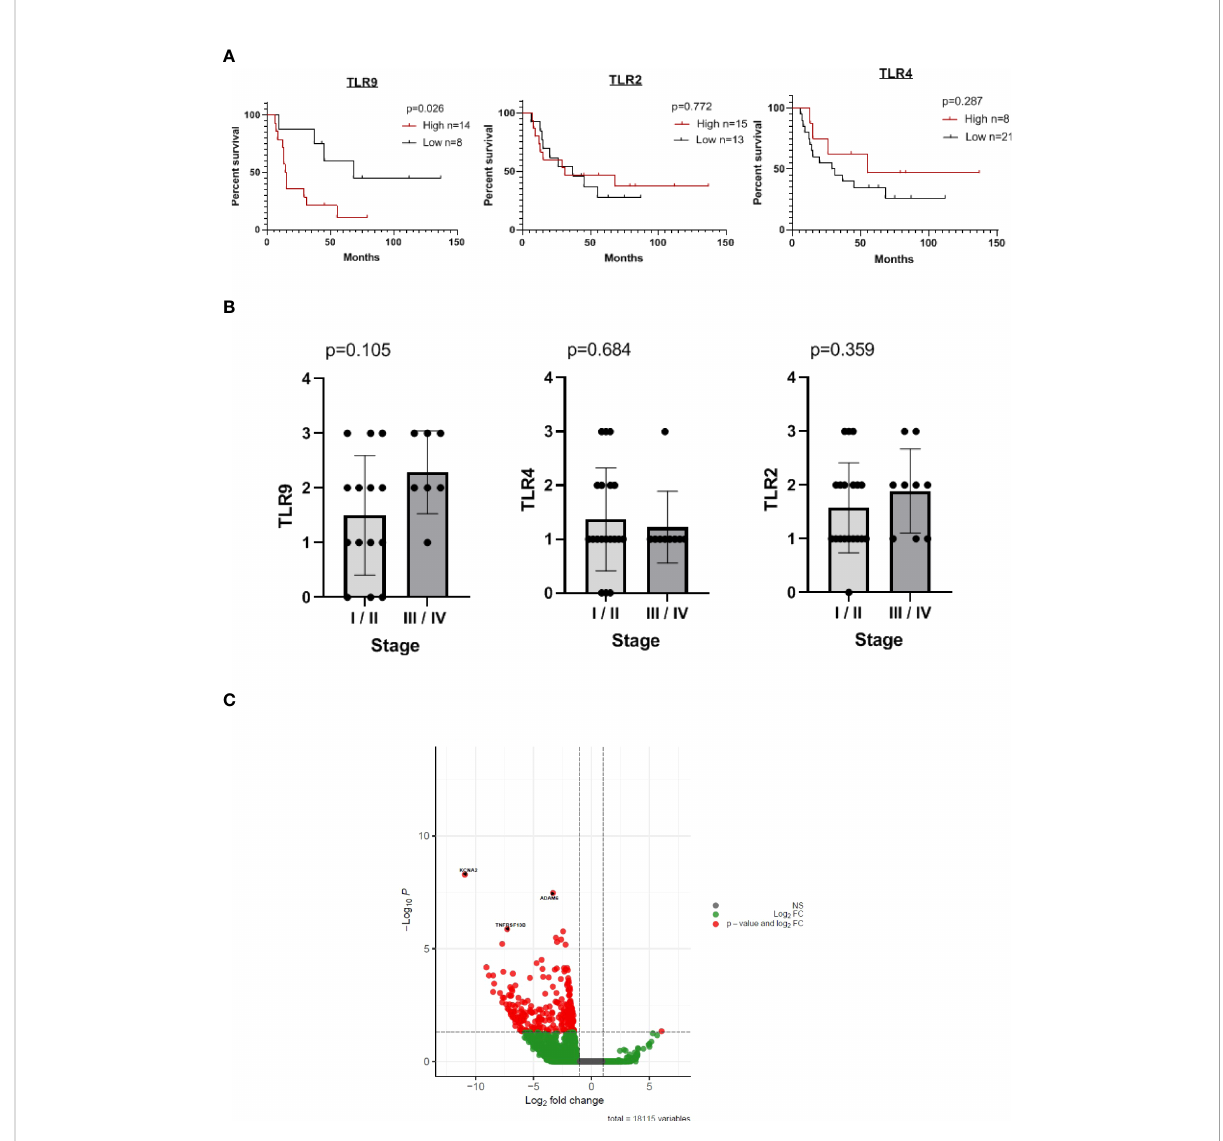
FIGURE 2 Patients with OSCC tumors expressing elevated levels of TLR9, but not of TLR2 or TLR4, exhibit a reduced 10-years overall survival. (A) Kaplan- Meier plots of overall survival of patients from the cohort under study. Patients were categorized as high or low TLR9, TLR4 and TLR2 as detailed in M&M. (B) Patients were categorized according to UICC- TNM criteria. Stages I and II were considered “ initial ” whereas stages III and IV were considered “ advanced ” . (C) Volcano plot showing the differential expressed genes in samples analyzed from the TCGA and categorized as TLR9 low and high according to their median expression value. The plot shows genes that have a signi fi cantly up-regulated expression in TLR9 high samples (red dots) based on both biological difference (absolute log2; estimated fold change) and statistical difference (-log10; p value). Negative log fold changes indicate that the expression is higher in the TLR9 high